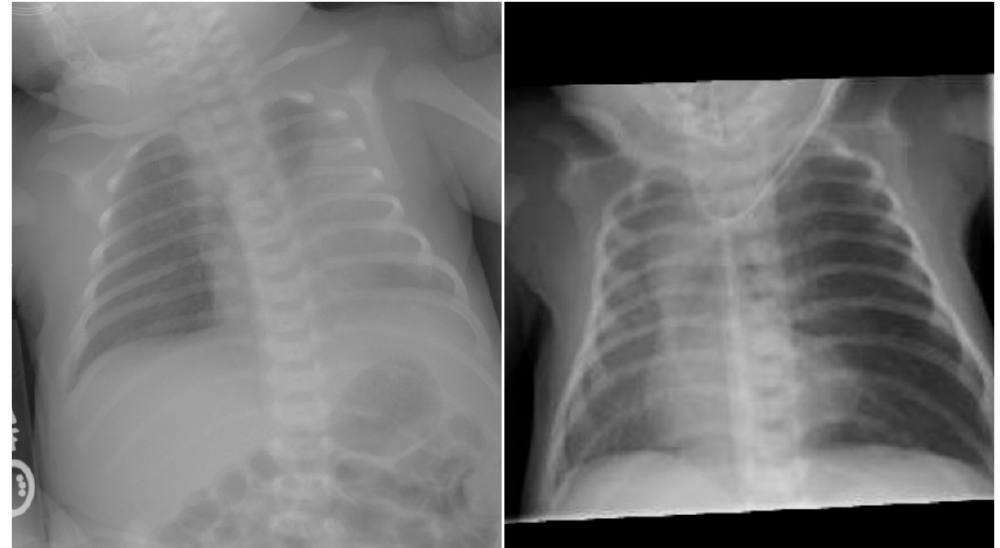
Figure 1. Left panel depicts anterio-posterior chest radiograph on the first day with left-sided opacification. Right panel reveals radiograph at 7 days with hyperinflation of the left and mediastinal shift.